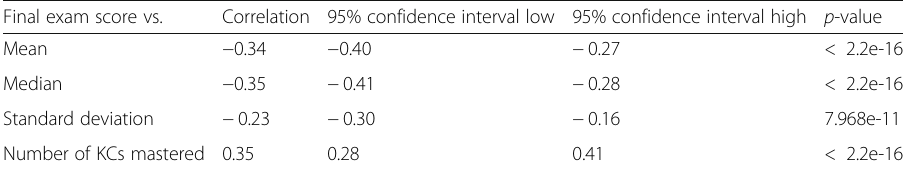
Table 11 Correlations between number of attempts and final exam score Final exam score vs.